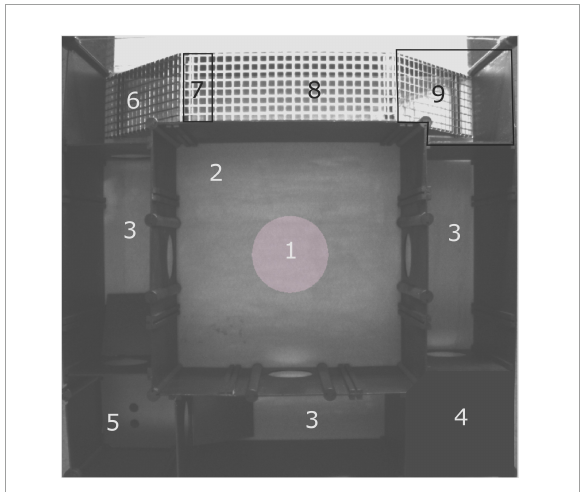
FIGURE1 Layout of the multivariate concentric square field TM (MCSF) test arena. (1) Central circle (CTRCI), (2) center, (3) corridors, (4) dark corner room (DCR), (5) hurdle with hole board and ramps to the adjacent corridors, (6) slope, (7) bridge entrance, (8) bridge and (9) beyond bridge zone.